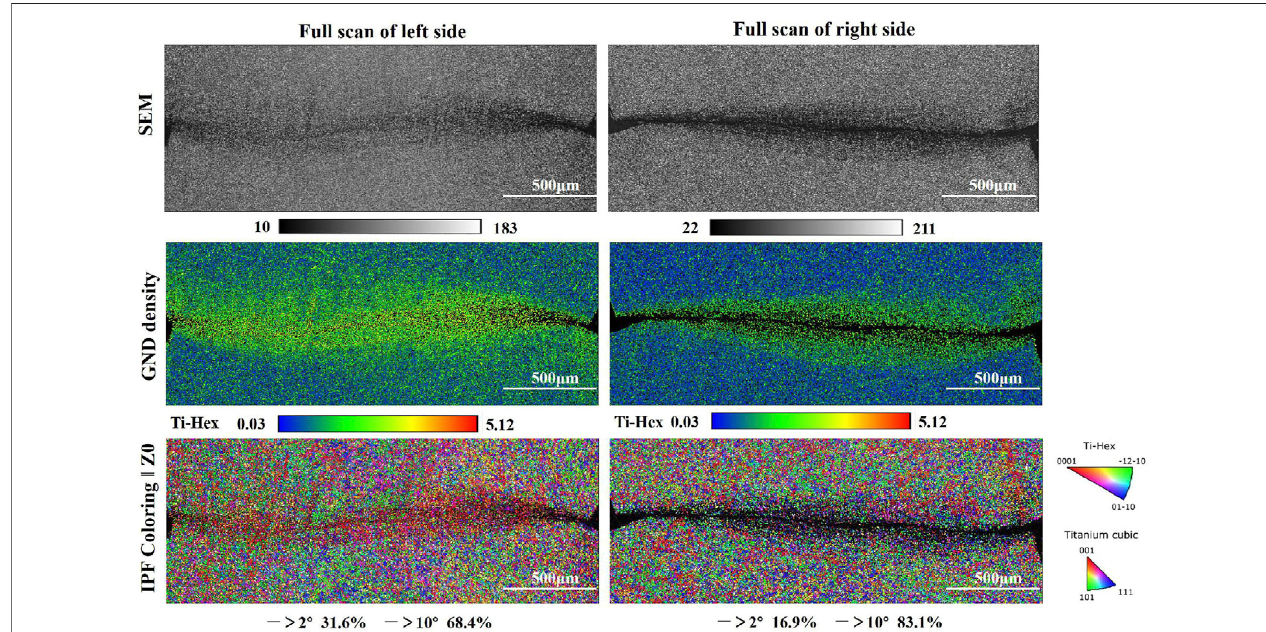
FIGURE 7 | The features of the hat-shaped sample in terms of back scattering (BC), geometrically necessary dislocation (GND) map, and the coupling analysis of inverse pole fi gure and grain boundary map (IPF + GB) at strain rate of 1.8 × 10 4 s − 1 .